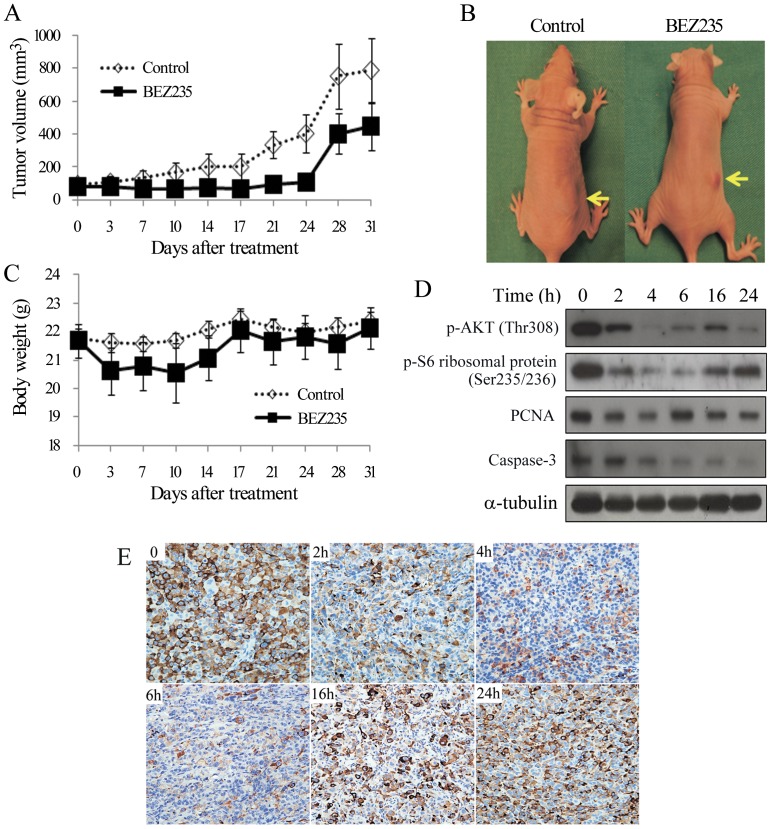
BEZ235 decreases p-AKT(Thr308), p-S6 ribosomal protein (Ser235/236), caspase-3, and retards the growth of ATC flank xenograft tumors without significant toxicity in nude mice.A, daily oral gavage of BEZ235 (50 mg/kg) represses 8505C tumor growth. The differences of tumor volume between BEZ235 and control group achieved statistical significance on days 21 and 24. Significance was lost on day 28, 4 days after treatment had been discontinued. B, representative mice with 8505C xenograft tumors (arrows) were photographed on last day of treatment (day 24). C, BEZ235 did not result in any weight loss, in treated and control mice (P>0.05 for both comparison). D, BEZ235 represses p-AKT (Thr308) and p-S6 ribosomal protein (Ser235/236) by 2 hours and caspase-3 by 4 hours in vivo. PCNA was slightly reduced at early period. E, expression of p-S6 ribosomal protein in tumor cells is detected by immunostaining at the indicated periods (magnification, ×200). These results were in consistent with Western blot results.